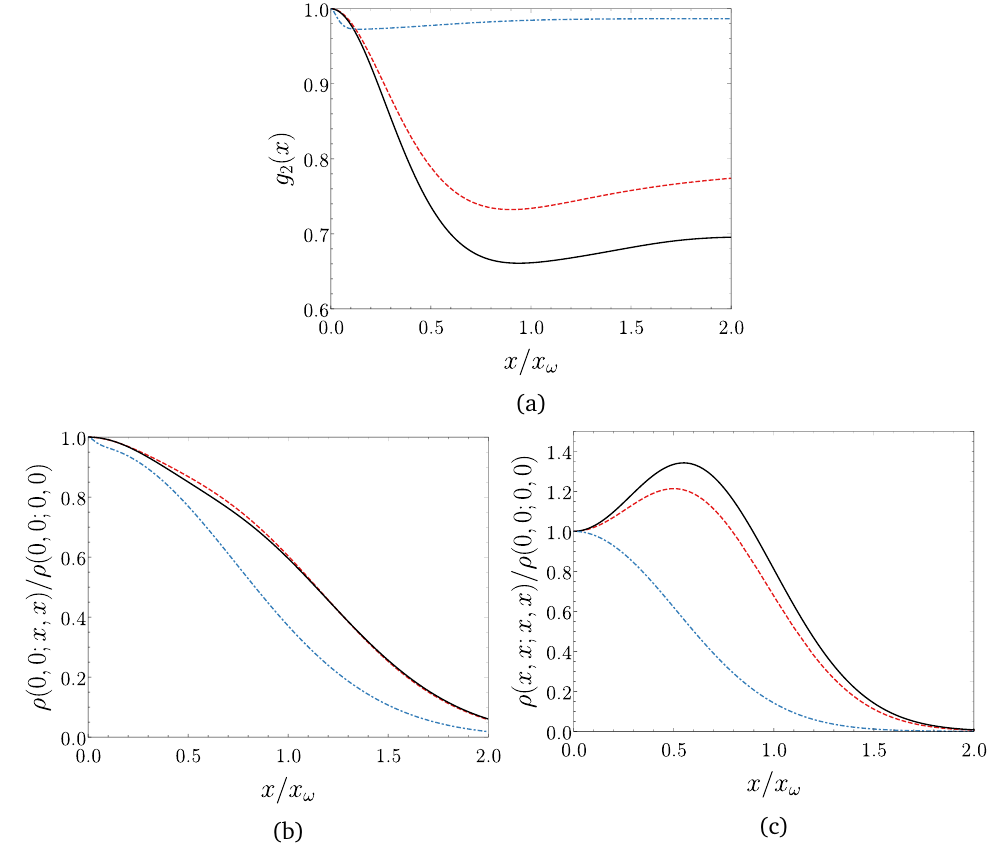
( x ) , b) off-diagonal matrix elements Figure 5: a) Off-diagonal correlation function g 2 and c) diagonal matrix elements of the reduced density matrix ρ . Black solid lines ab correspond to numerical results for λ x ω = 30, red dashed ones to point-like hard- core bosons and blue dash-dotted lines correspond to the prediction of the coboson ansatz for N = 2 and λ x ω = 30. Details are provided in the main text and in Ap- pendix D. Notice that the vertical axis of subplot (a) does not begin at